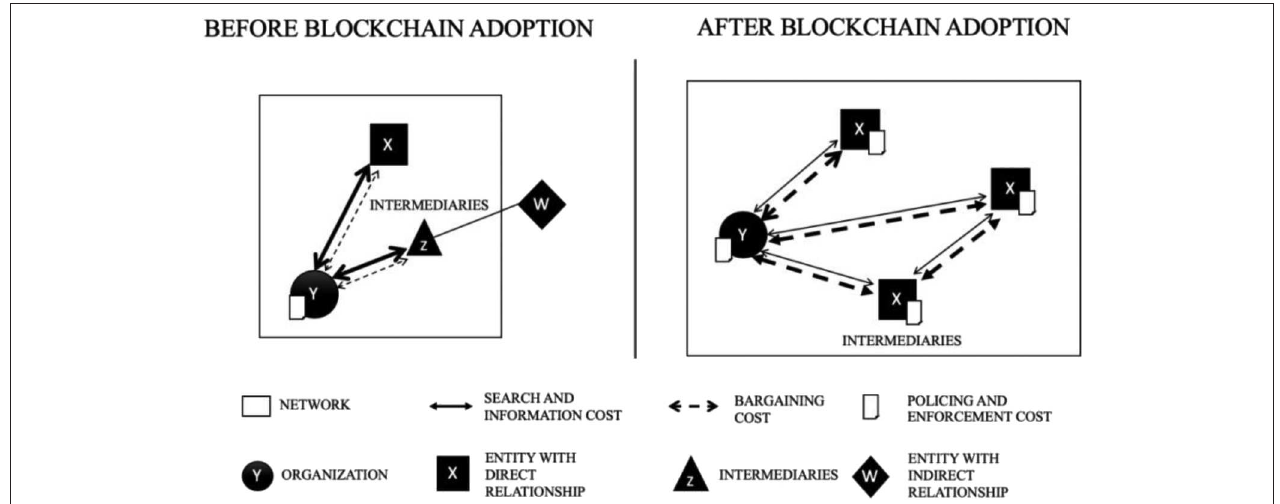
FIGURE 1 | The transformation of transaction costs in the adoption of blockchain technology. The thicknesses of the line represent the amount of costs. Before the adoption of blockchain, organization Y had a direct transaction with X and indirect transactions with W through the intermediary, entity Z and supervised them by a contract. The traditional intermediary Z is either removed or transformed into a new role after adopting blockchain. The nodes are connected, lowering the search and information costs due to the shared ledger. Since the same smart contracts are also owned by each entity, the enforcement of rules is also automatically checked. Therefore, the policing and enforcement costs can be greatly reduced; however, the negotiation efforts would dramatically increase since the pre-defined rules are required for fulfilling each participant’s expectations.